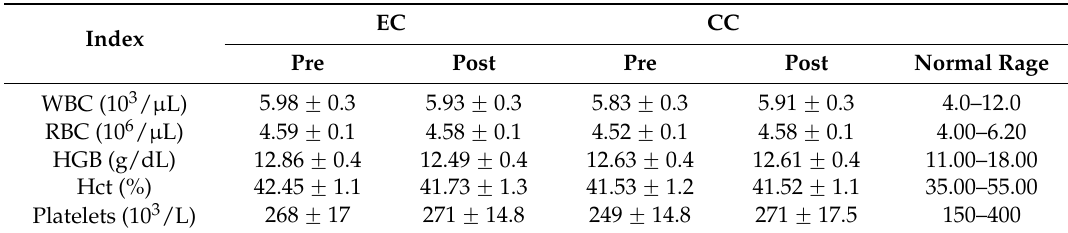
Table 3. Complete blood count parameters following polyphenol-enriched (EC) and plain (CC) yogurt consumption (Mean ˘ SEM).